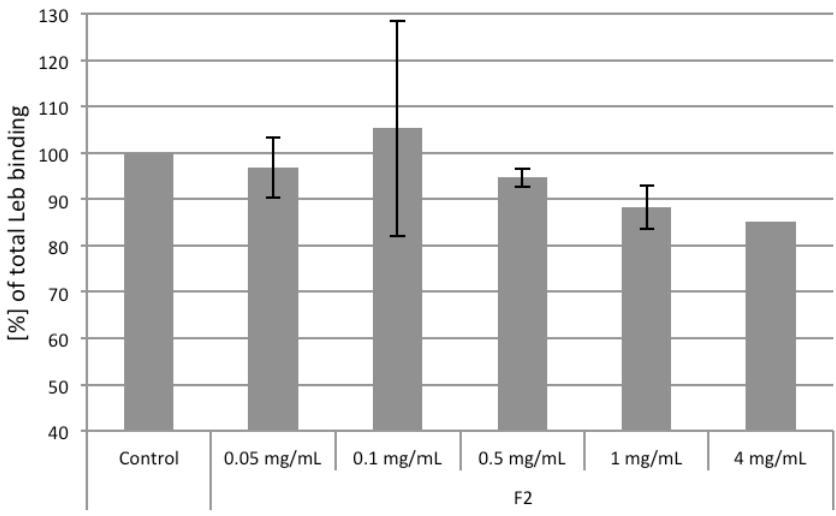
Figure 8. Influence of R. nigrum arabinogalactan proteins F2 on H. pylori strain 17875/Le b binding to Le b -HSA. Data from two independent assays (4 mg group only with one assay, due to limited substance amount) are related to the Le b -HSA binding of the control (only 17875/Le b together with Le b , = 100% Le b binding). Bar of the control group: SD, F2 test groups: range between the two